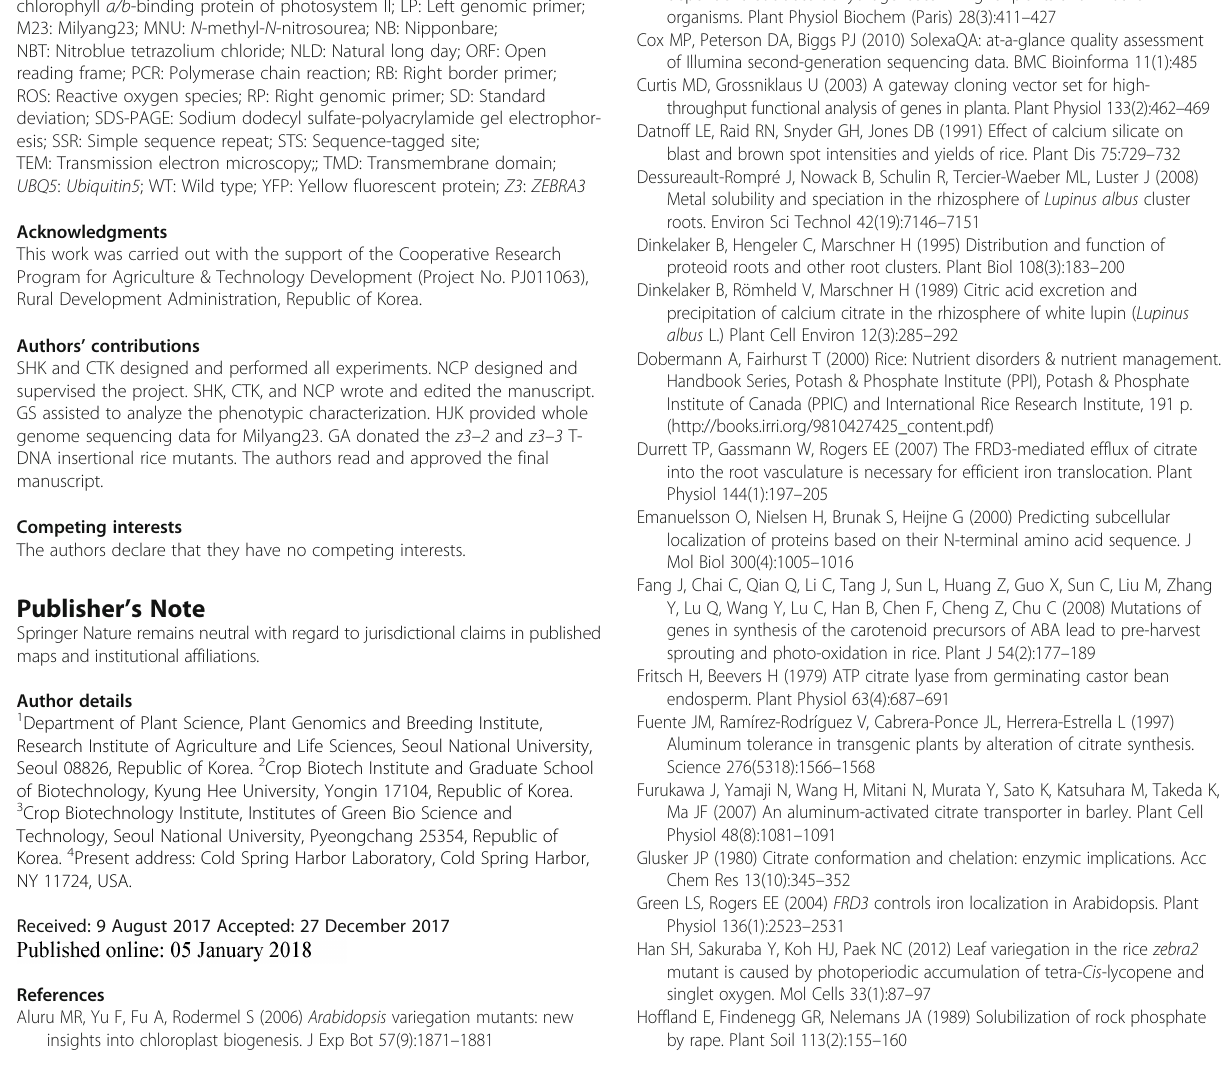
Additional file 6: Figure S6. Analysis of reactive oxygen species (ROS) in the z3 mutant leaves. a-b Hydrogen peroxide (H2O2) and superoxide anion radicals (O2-) in flag leaves of the WT and z3 mutants at 160 DAS grown under natural long day conditions were visualized by staining with DAB (a) and NBT (b), respectively. Leaves before (left) and after (right) staining are shown. (PDF 497 kb) Additional file 7: Figure S7. Transmission electron microscopy analysis of chloroplasts in the z3 mutant leaves. a-c Chloroplasts in the green leaves of the WT (a) and in the dark-green (b) and green (c) sectors of the z3 mutant leaves. Flag leaves of the 150-day-old WT and z3 mutant grown under natural long day conditions were sampled for analysis. G, grana thylakoid. Scale bars = 0.5 μ m. (PDF 955 kb) Additional file 8: Table S1. Primers used in this study. (PDF 1453